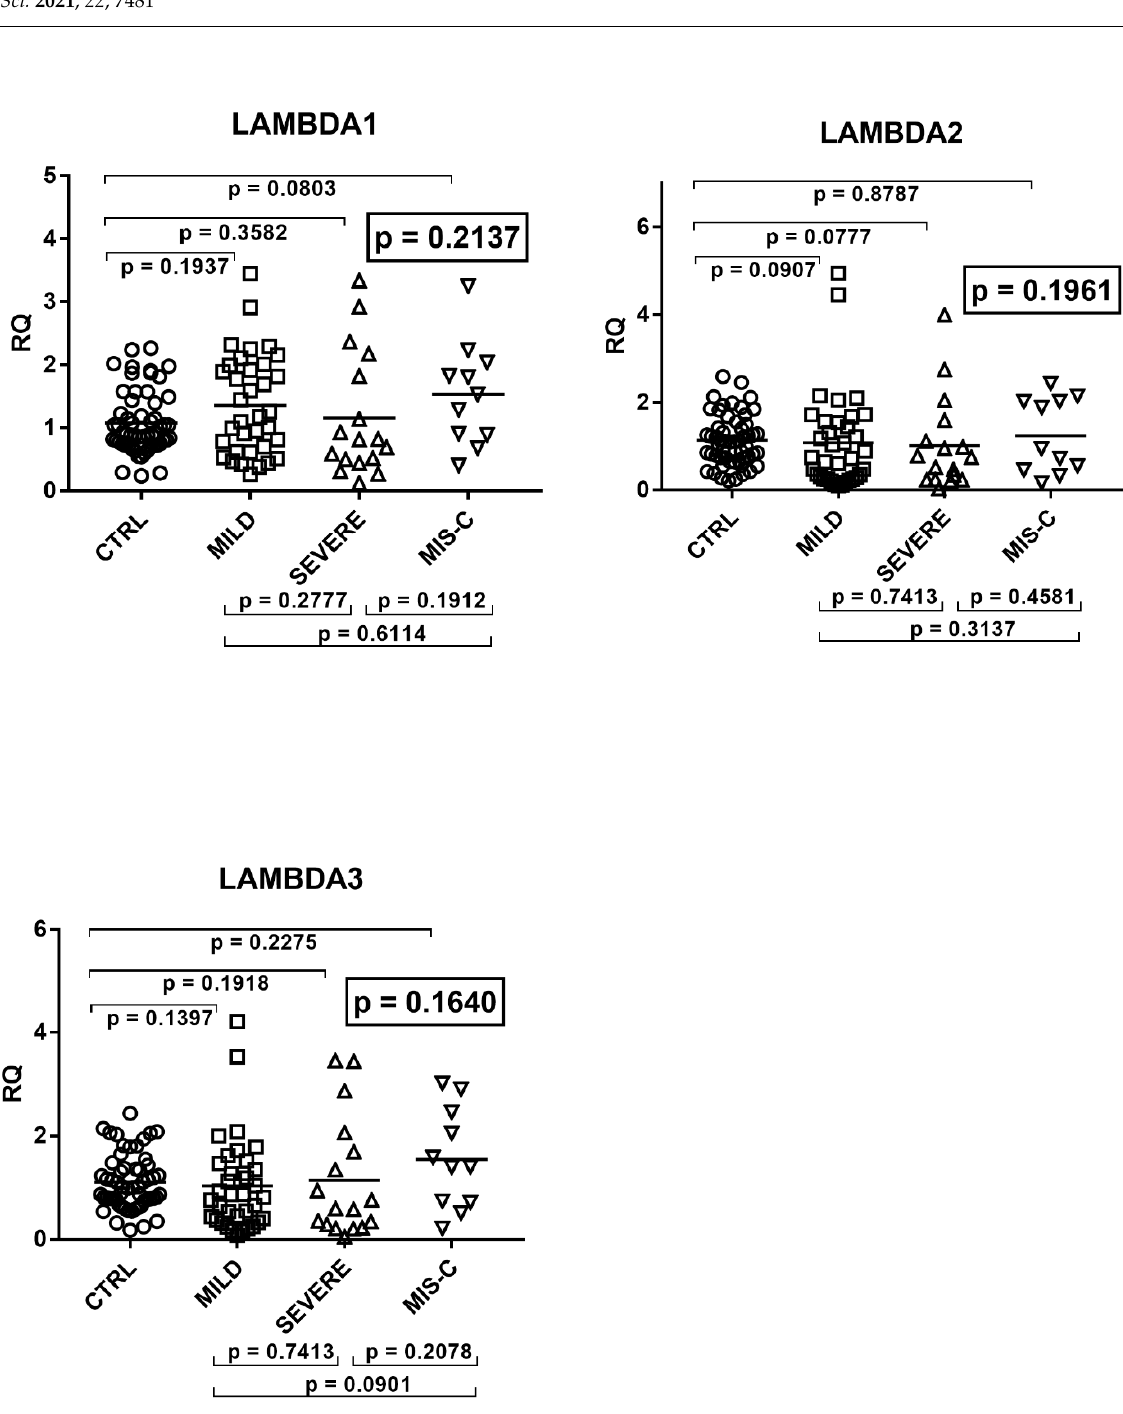
Figure 3. Expression of type III interferons in whole blood from 64 children with SARS-CoV-2 infection and 60 uninfected children. CTRL: uninfected control children. MILD: infected children with mild/moderate symptoms. Severe: infected children with severe disease. MIS-C: infected children with multisystem inflammatory syndrome. RQ: relative quantification. Circles, squares, and triangles show the mean of three individual measurements, horizontal lines the median values. Median values–interquartile range (IQR) of IFN-IIIs: LAMBDA1: CTRL: median 0.90, IQR 0.75, 1.40; MILD: median 1.17, IQR 0.66, 1.96; SEVERE: median 0.81, IQR 0.50, 1.82; MIS-C: median 1.53, IQR 0.90, 1.93. LAMBDA2: CTRL: median 1.11, IQR 0.74, 1.46; MILD: median 0.73, IQR 0.28, 1.54; SEVERE: median 0.75, IQR 0.24, 1.11; MIS-C: median 0.94, IQR 0.50, 2.02. LAMBDA3: CTRL: median 1.00, IQR 0.77, 1.38; MILD: median 0.84, IQR 0.40, 1.38; SEVERE: median 0.60, IQR 0.29, 1.69; MIS-C: median 1.40, IQR 0.73, 2.25. Statistical analysis: one-way ANOVA was used to compare the transcriptional levels of each target between the four groups of children. The Mann–Whitney test was used to compare the transcriptional levels of each target between each group of children with each other.